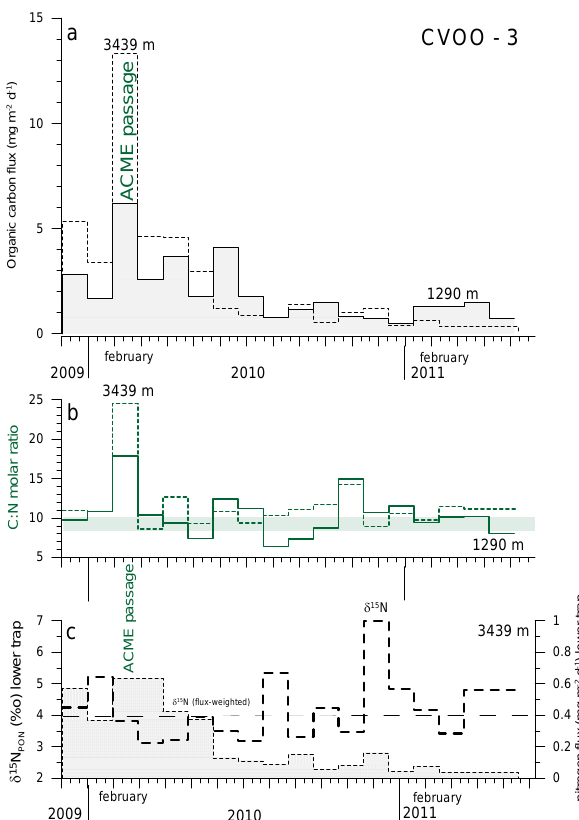
Figure 5. Organic carbon fluxes collected with the upper and lower sediment traps at CVOO-3 (a) and the corresponding molar C:N ratios of the organic matter (b) . Upper and lower trap fluxes are correlated ( r 2 = 0.7, N = 17). Note the unusually high C:N ratios in February 2010 recorded in both traps. Typical molar C:N ratios (8–10) for degraded marine organic matter off north-western Africa (Fischer et al., 2003, 2010) are indicated by a green stippled hori- zontal bar in (b) and (c) δ 15 N values for organic matter sampled by the lower trap (stippled thick line) shown together with the total ni- trogen fluxes. The flux-weighted mean δ 15 N value of 3.98 is shown as